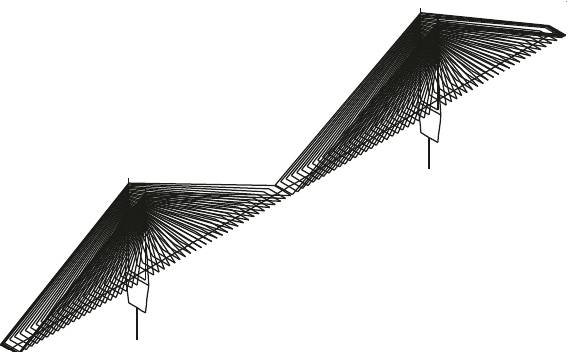
Figure 2: FEM model of a cable-stayed